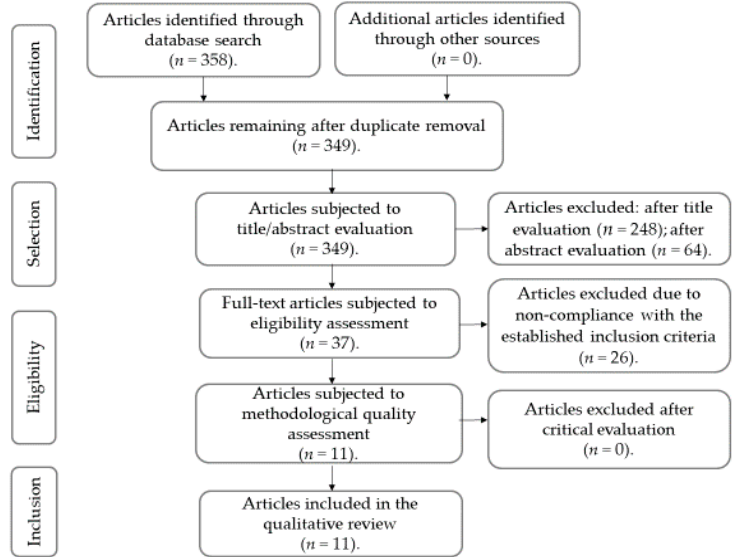
Figure 1. PRISMA flowchart detailing the search’s results and the studies’ selection / inclusion process (based on the method suggested by Moher, Liberati, Tetzla ff , Altman and the PRISMA group)